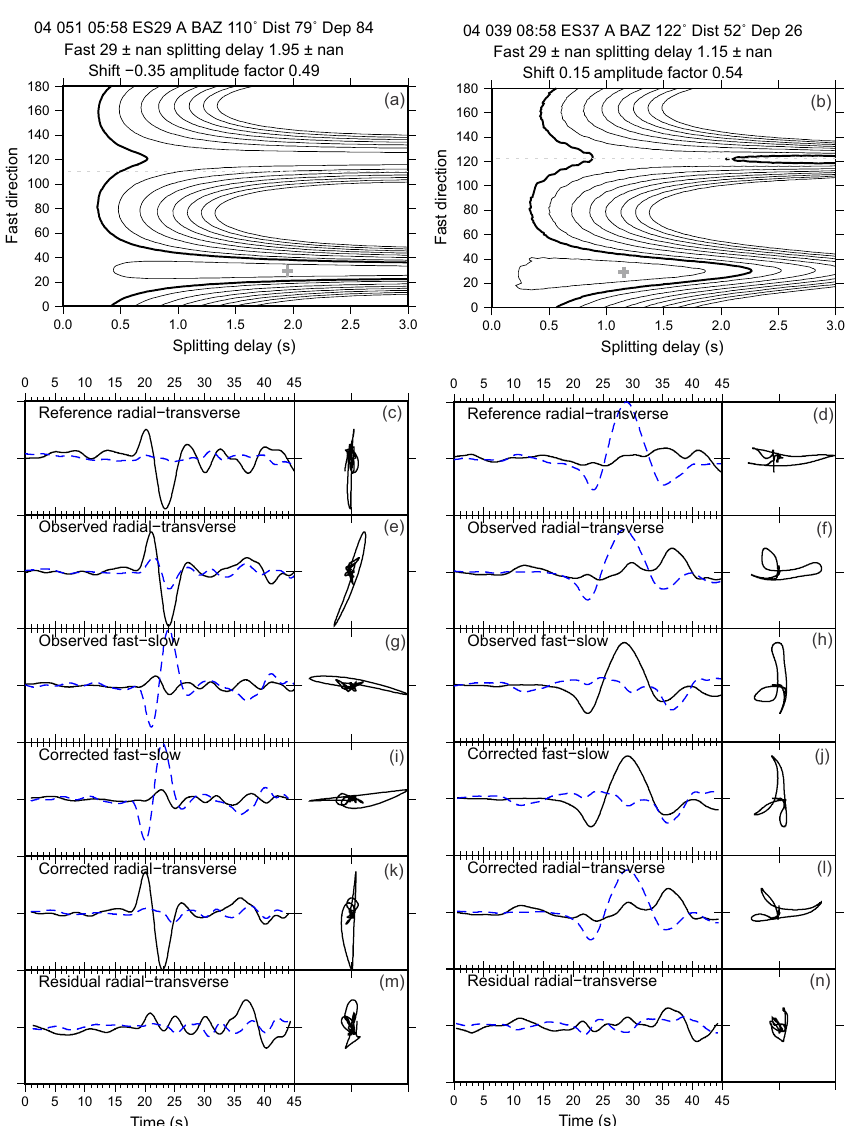
Figure 5. An example of null-anisotropy measurement based on the RST at stations ES29 and ES37. Panels on the left side represent the splitting measurement recorded at station pair ES27 (reference station)–ES29 (target station), and those on the right side represent the splitting measurement recorded at station pair ES05 (reference station)–ES37 (target station). The explanation for each panel is the same as in Fig.